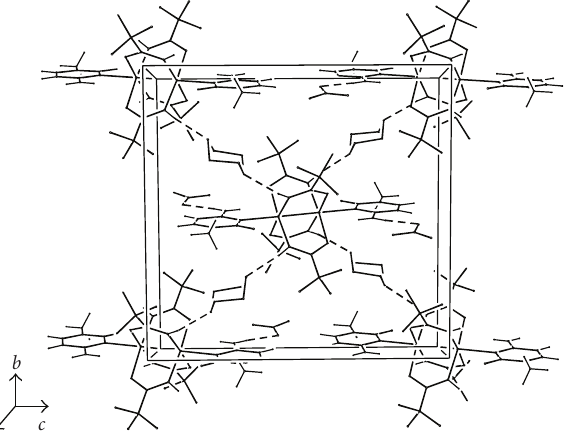
Figure 4: View of the crystal packing along the a direction for [Pt 2 { HN = C(Bu t )O } 4 (1-MeC) 2 ](NO 3 ) 2 · 2(1,4-dioxane). Since the tert -butyl groups and the dioxane molecules are disordered, only one occupation site is shown for